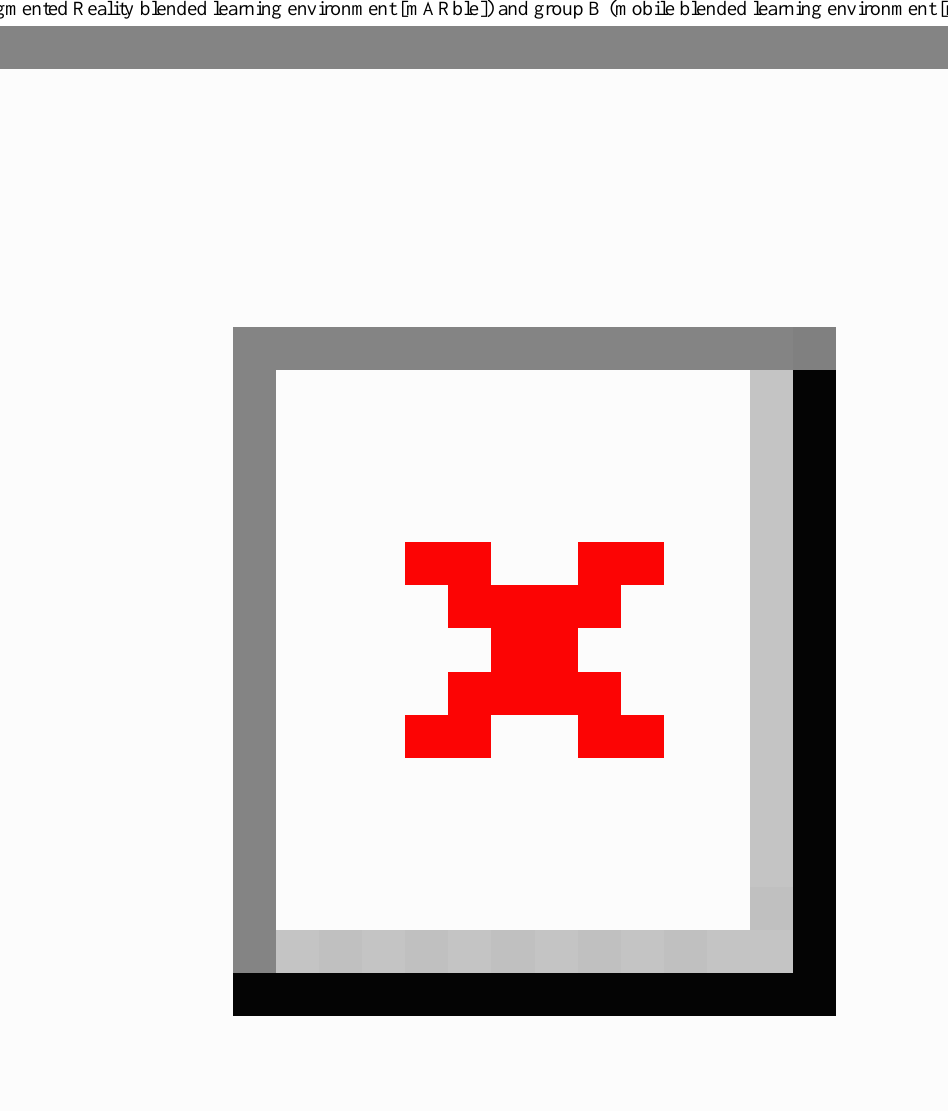
Figure 4. Graphical representation of the distribution of time spent on interacting with the markers as well as the flashcards, stratified for group